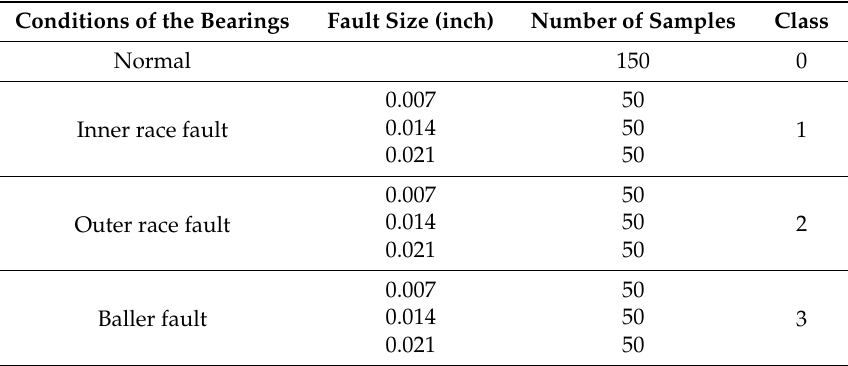
Table 2. Datasets obtained at the motor speeds of 1750 rpm and 1772 rpm on the CWRU bearing experimental platform.